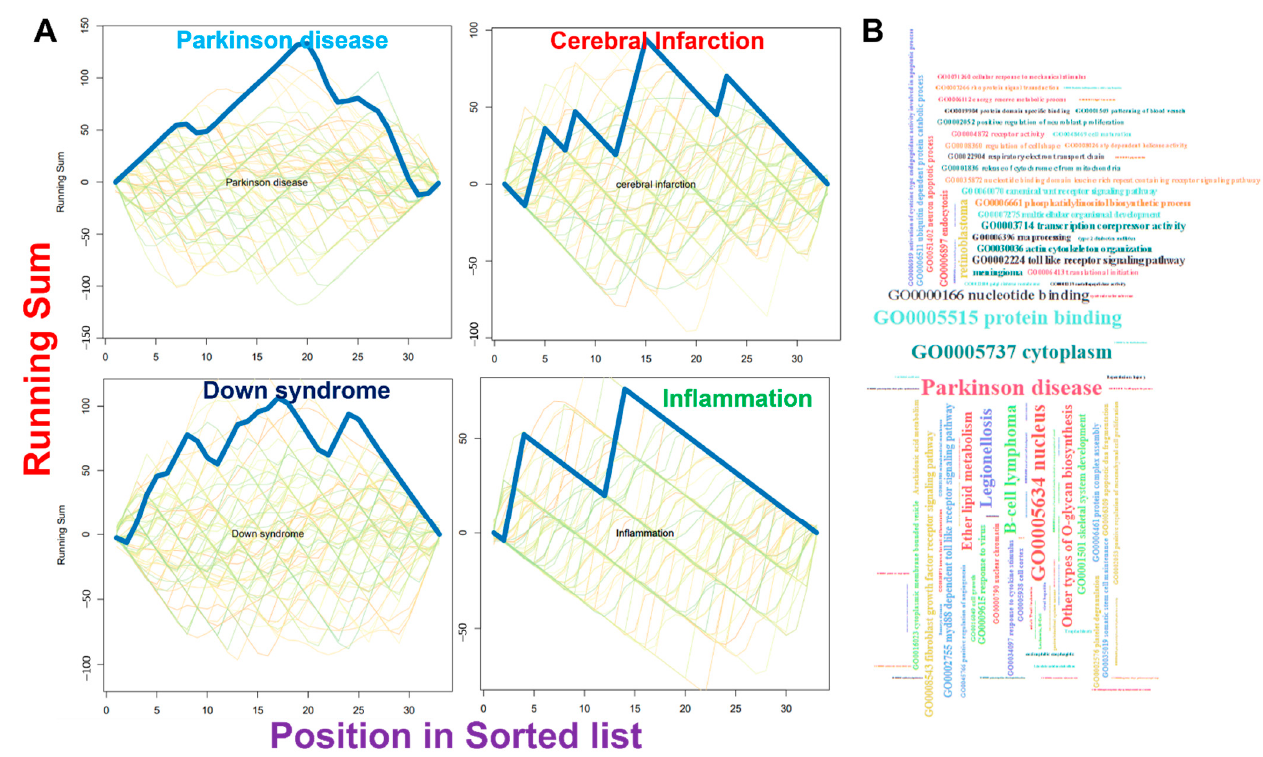
Figure 5. MicroRNA (miR) regulatory network enrichment of the DEGs. ( A ) Specific diseases enrichment plot and ( B ) cloud plot of the total enrichment of the DEGs.